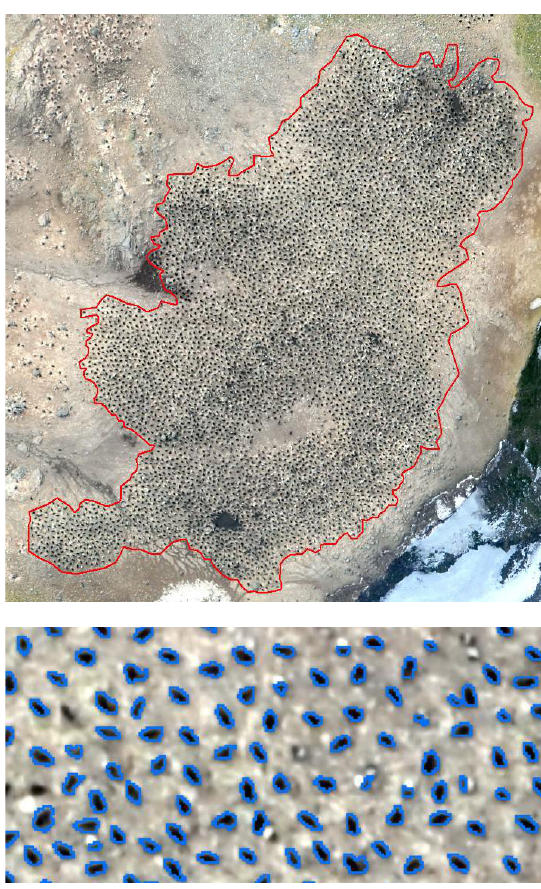
Figure 8. The result of automatic estimation of the counts of objects (penguins) (Image